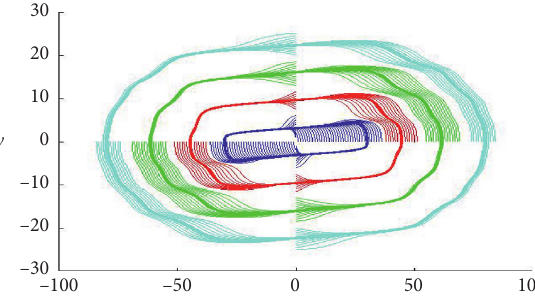
Figure 1: Attractor and some transient responses for equation (1). Attractors are plotted with thicker lines when transient responses are shown with thinner